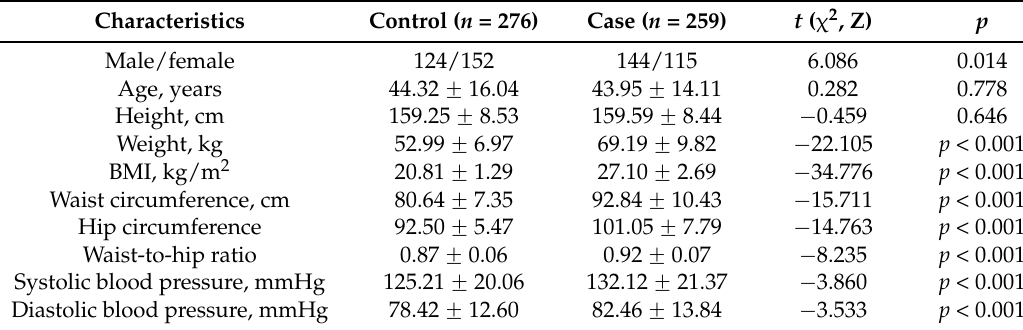
Table 2. General characteristics and serum lipid levels between the control group and case